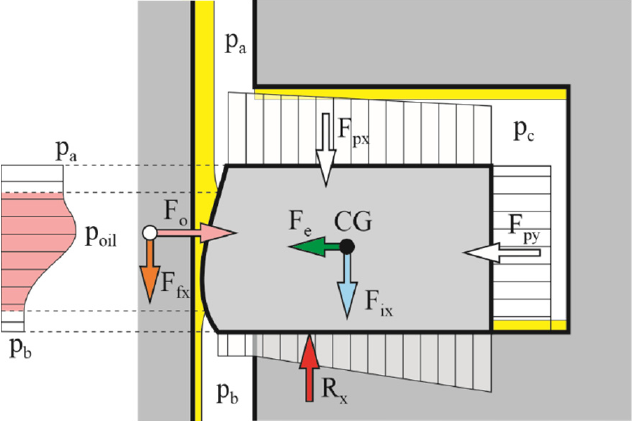
Figure 2. Forces acting on the ring. The radial position of a ring in the groove (outer ring diameter) arises from the liner diameter at a given height and the minimum oil film